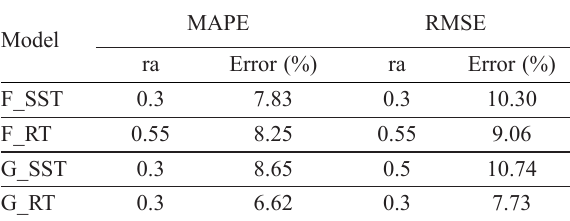
Table 2. Sensitivity analysis results